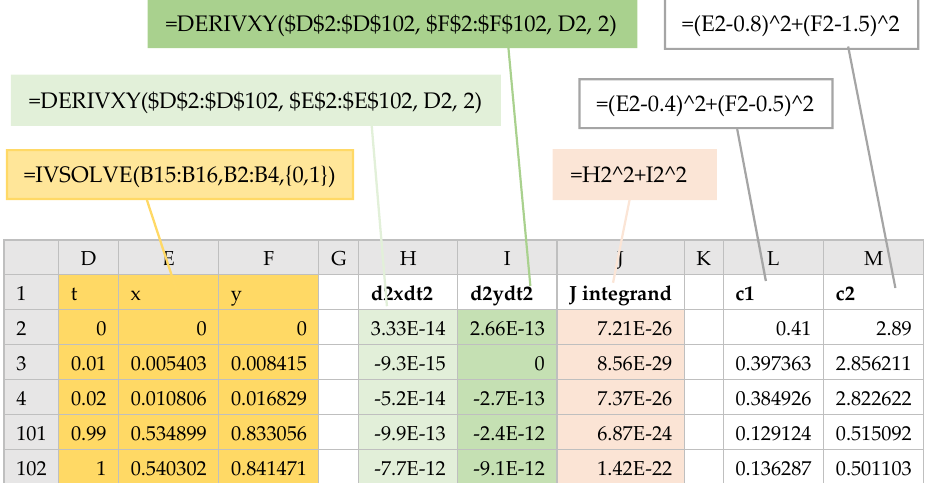
Figure 15 . Partial display of the IVP (18)–(20) solution obtained by IVSOLVE formula (24), and dependent generated values needed to define the cost index and constraints formulas of problem 3.3.